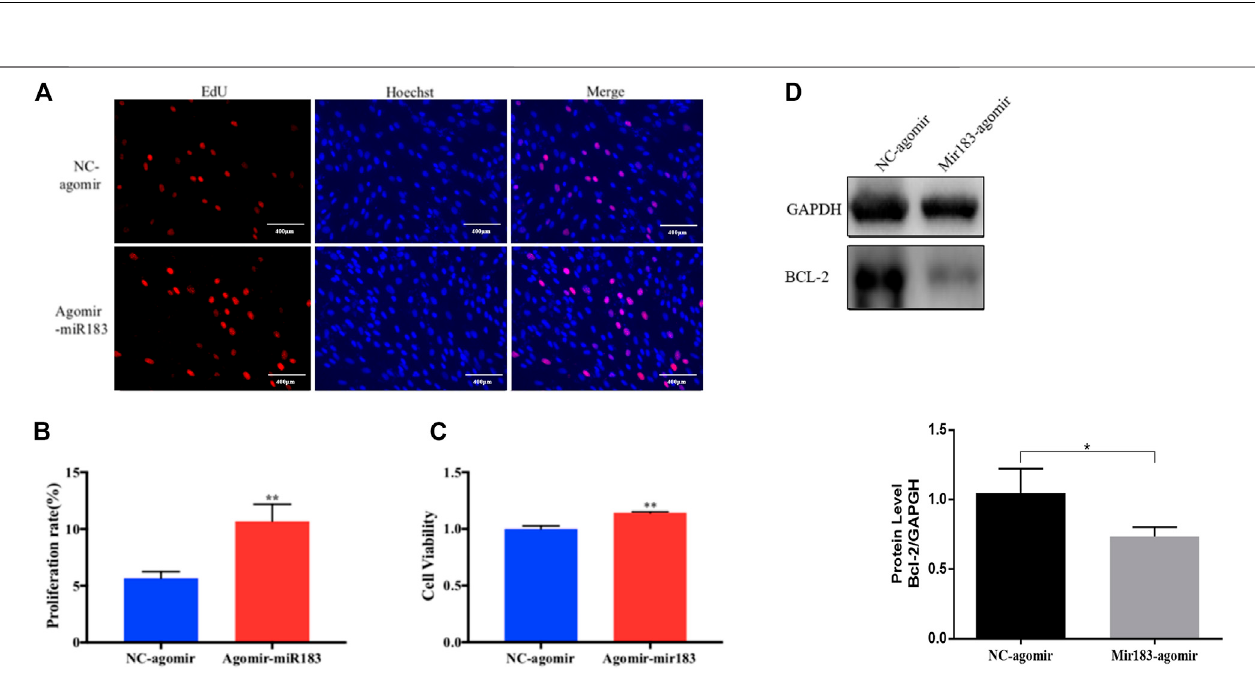
FIGURE 6 | Effect of mir-183 on the proliferation and apoptosis of granulosa cells. (A) EdU staining test was used to detect the proliferative capacity of granulosa cells.Redrepresentsnewly-producedEdU-positivecellsandbluerepresentsthenuclei(Hoechst);thescaleis100 μ m. (B) Quanti fi cationofEdU-positivecells, n (cid:1) 3. (C) CCK-8 assay to assess the viability of granulosa cells at 24 h, n (cid:1) 5. (D) The amount of apoptosis protein Bcl-2 expression. GAPDH protein was used as an internal reference. The results are expressed as mean ± standard error, n (cid:1) 3; NS: no signi fi cant difference; *, p < 0.05; **, p < 0.01.